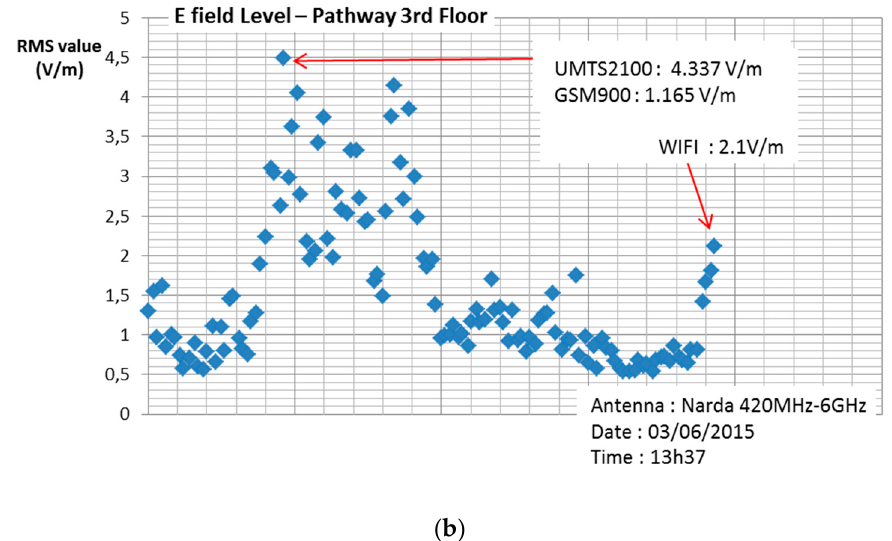
Figure 4. ( a ) Static exposure along a pathway: Example of electromagnetic field field measurement pathway—Library Part-Dieu, Level 3 (digital documentation area); ( b ) example of electric field measurement results on a pathway—Library Part-Dieu, Level 3 (digital documentation area).